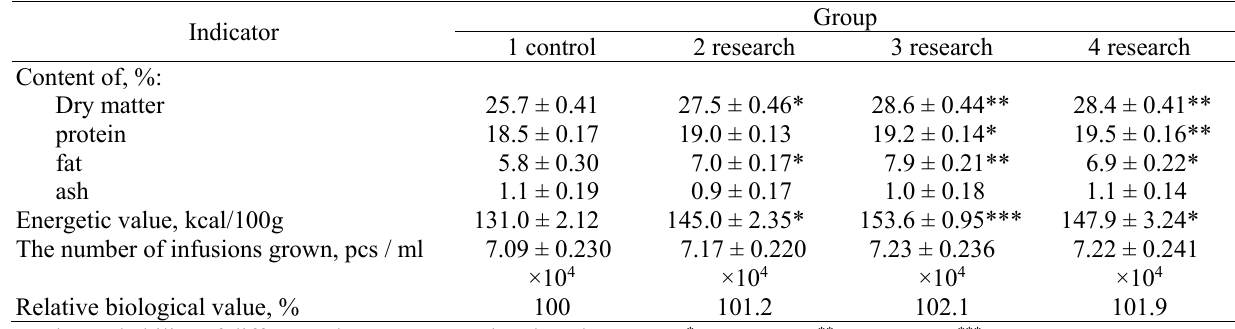
The chemical composition and biological value of the thigh muscles and tibia (Х ± S х , n =